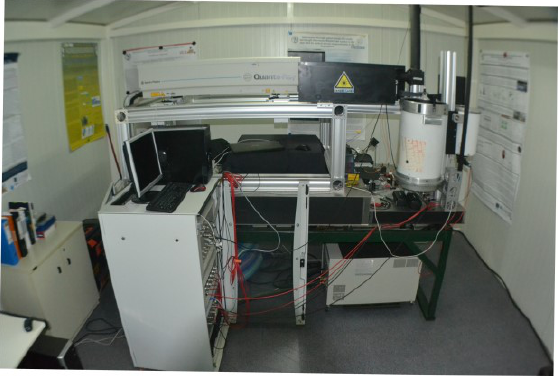
Figure 1 . The LRSU elastic-Raman lidar (EOLE). A second laser is used to emit vertically polarized beam at 355 nm (>99%), while an additional telescope (200 mm diameter, Cassegrainian) with focal length f=1000 mm, collects the elastically backscattered lidar signals at 355 and 532 nm (at 2 polarization